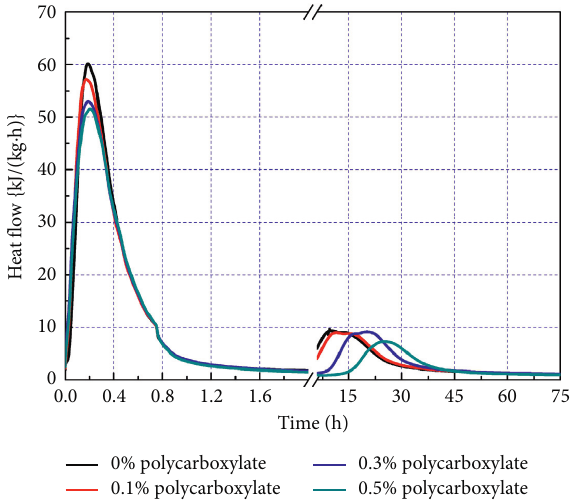
Figure 7: Effect of PCE-2 dosage on hydration heat flow of cement pastes with 10% fly ash.